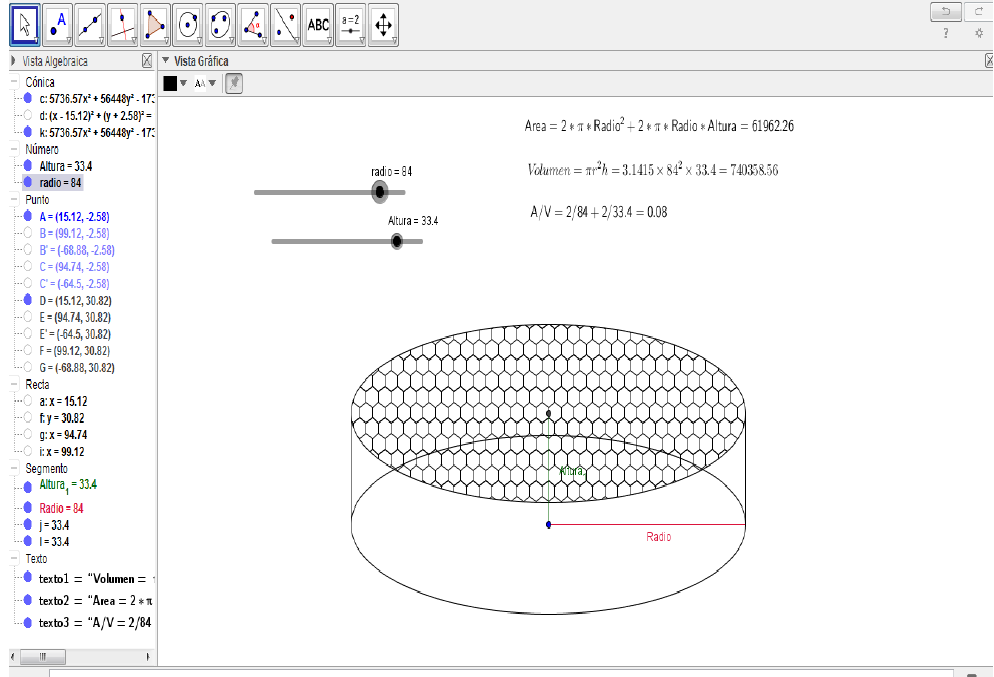
Figure 4. Ratio A/V and its dependence on the values of radius and height . Figure 4. Ratio A / V and its dependence on the values of radius and height.